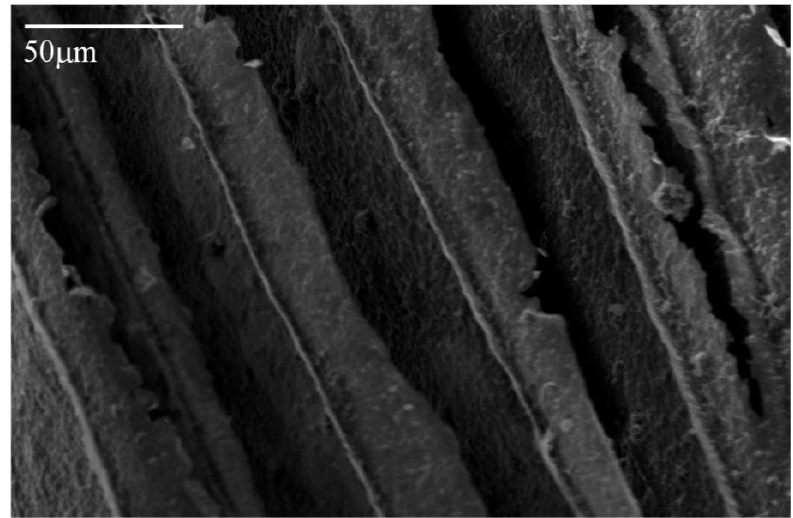
Figure 2. SEM (Scanning Electron Microscope) image of the microstructure of a 5 wt.% Na + -MMT/2.5 wt. % (Nanocor Inc. PGW grade, Chicago, IL, USA) AI-30 composite with 2 equivalents of amine.